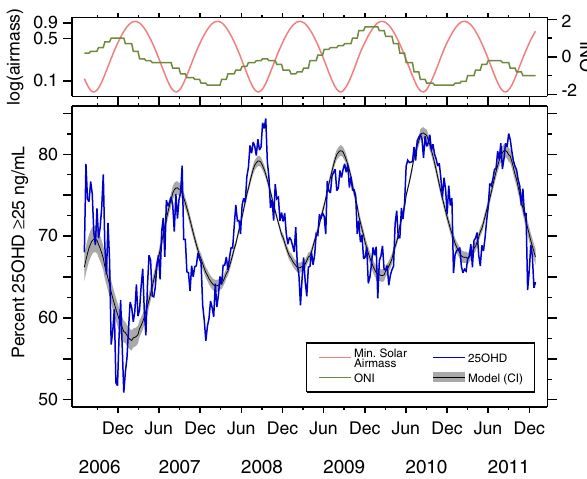
Figure 2. Time series plot of 25OHD data and covariates. Top panel plots model covariates. Left axis: logarithm of minimum solar airmass, 8-week lag (light red, on log scale, thus double-log); right axis: Oceanic Nin˜o Index (green). Bottom panel plots proportion of serum samples testing § 25 ng/mL (blue), and model (black), 95% confidence bounds (gray), from model 3 in table